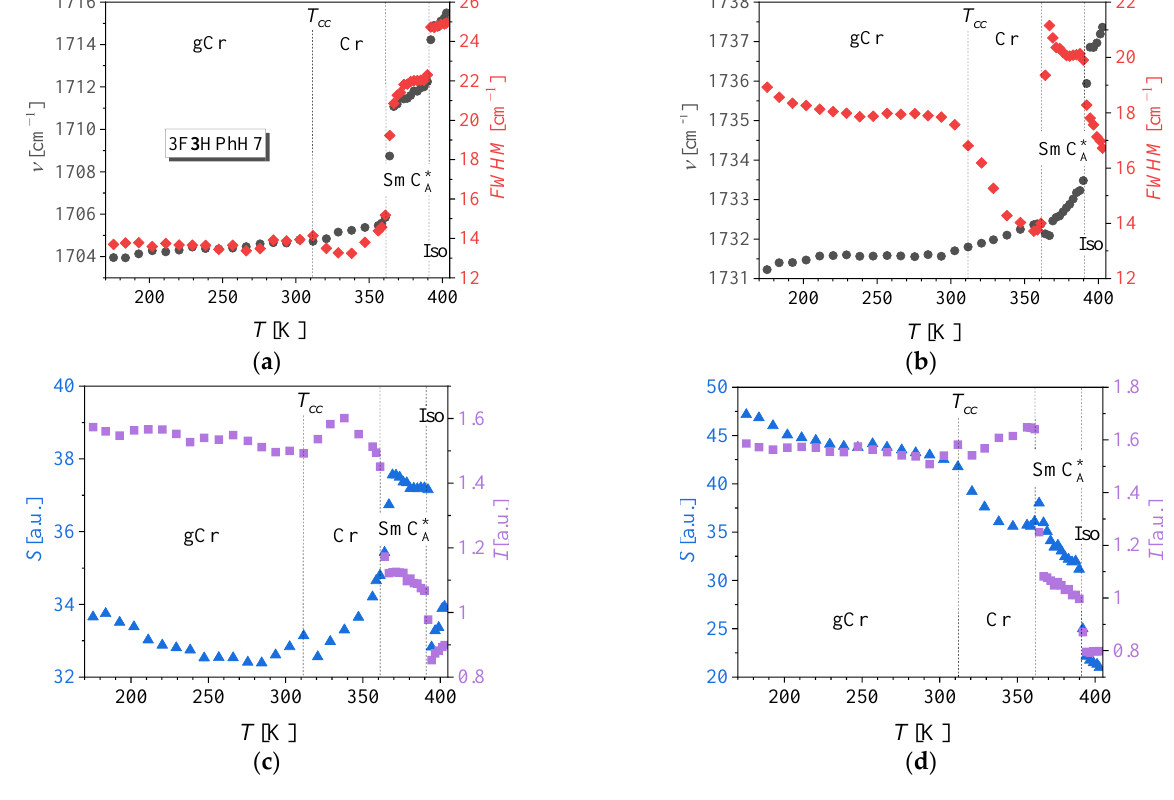
Figure 7. Temperature dependence of wavenumber ν and full width at half maxima FWHM ‘s ( a , b ), areas S and intensity of the bands I ( c , d ) related with the stretching vibrations of the (C=O) chiral_c. ( a , c ) and (C=O) core ( b , d ) bands registered upon heating of the 3F 3 HPhH7 after fast cooling. The error bars ale smaller than the symbols, if not explicitly stated otherwise.